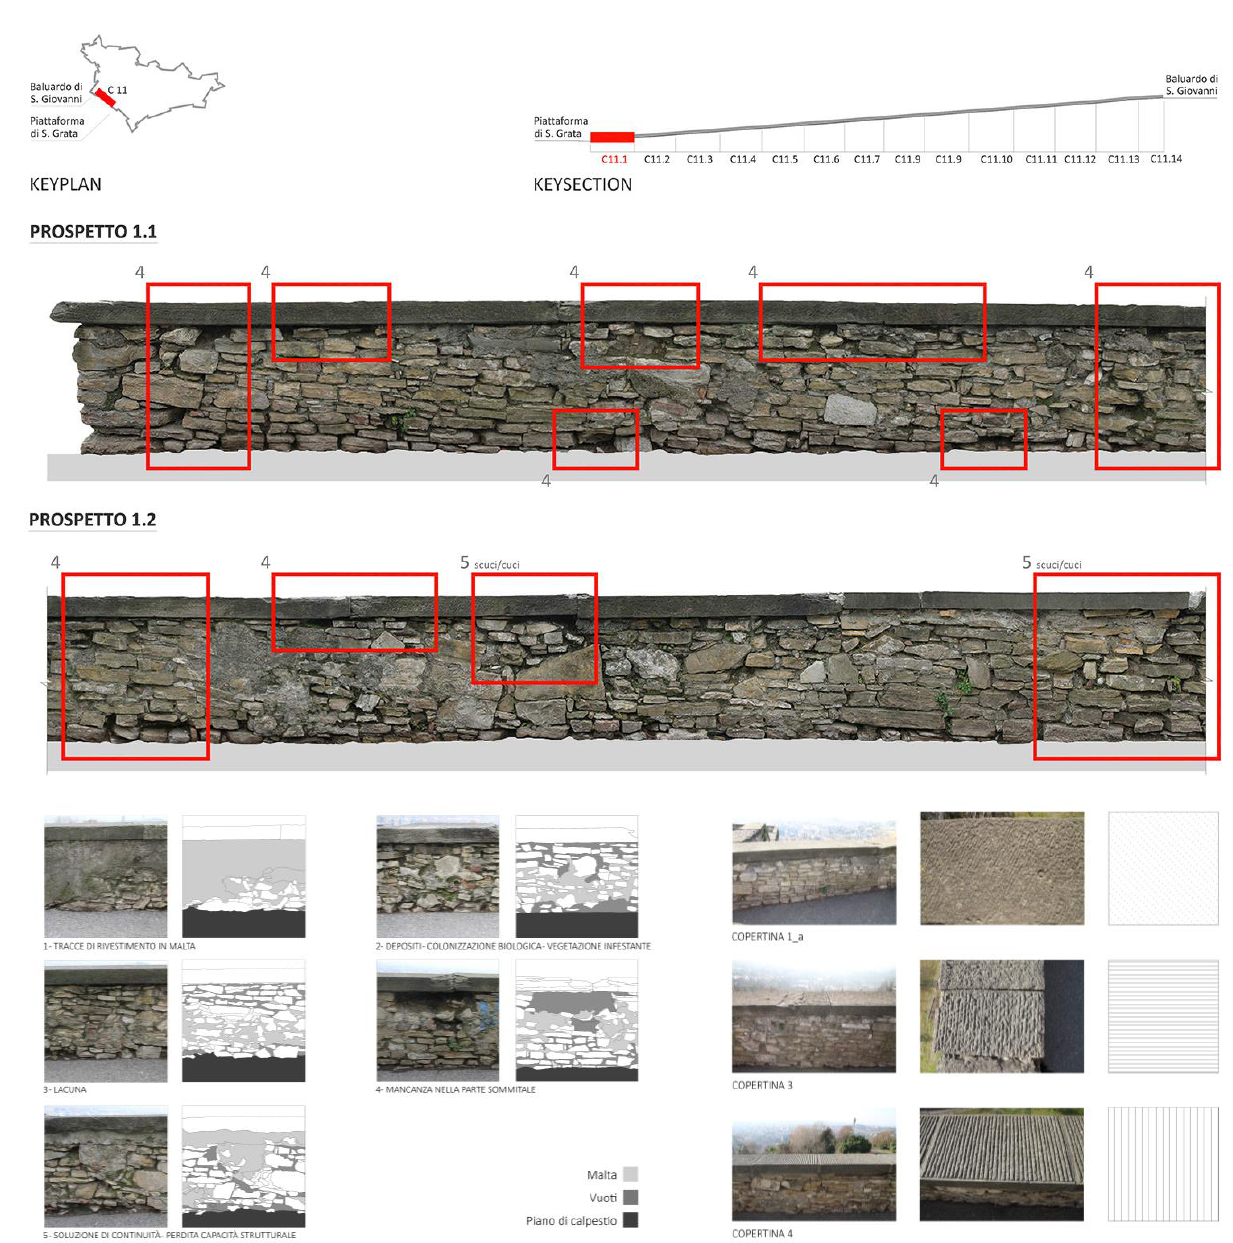
Figure 3. Detail of the parapet along the ‘Cortina di Santa Grata’ with front and top deterioration mapping (Campus et al.